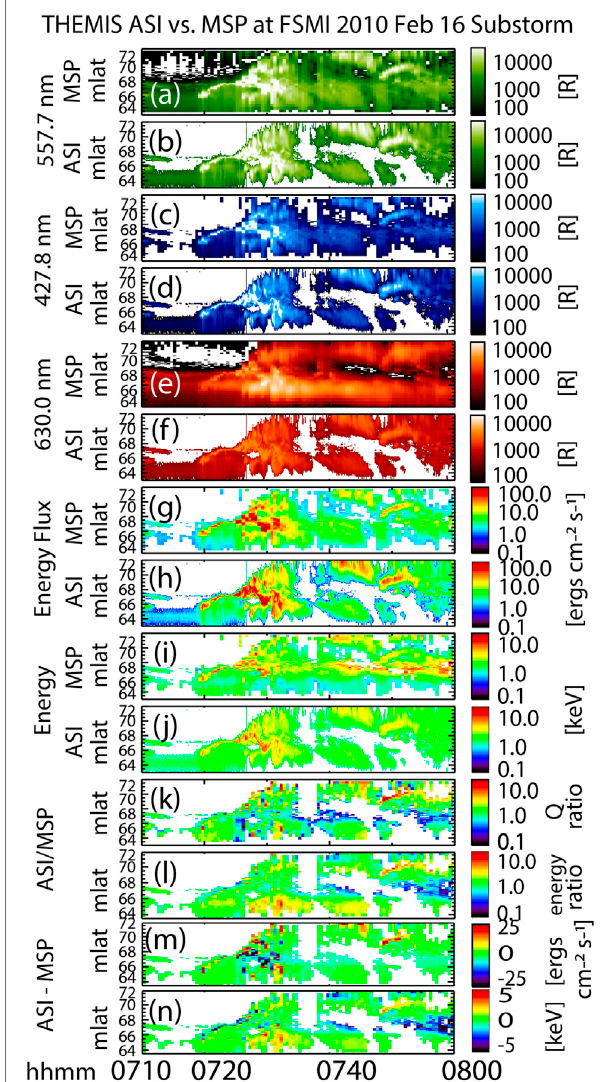
FIGURE 4 | Comparison between MSP data and THEMIS ASI data. Plots arekeograms, which display magnetic latitude on the y -axis and time on the x -axis. The visual is therefore the auroral evolution along a single line of longitude over time. (A) MSP 557.7 nm intensity [R]. (B) ASI 557.7 nm intensity [R]. (C) MSP 427.8 nm intensity [R]. (D) ASI 427.8 nm intensity [R]. (E) MSP 630.0 nm intensity [R]. (F) ASI 630.0 nm intensity [R]. (G) MSP determined energy fl ux using color ratios as input to the B3C-generated look- up table described in Background and Overview . (H) ASI determined energy